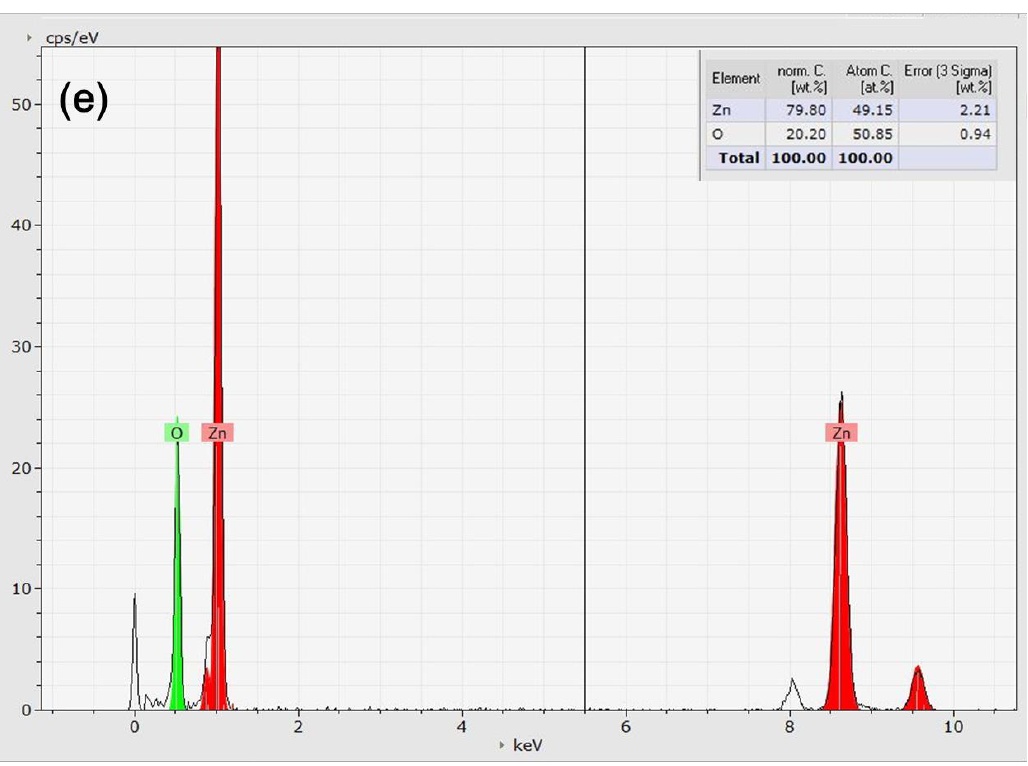
Catalysts 2019 , 9 , x FOR PEER REVIEW 7 of 12 Figure 6. ( a ) Low-resolution transmission electron microcopy image of ZnO NS after calcination. ( b ) High-resolution transmission electron microcopy image of ZnO NS (upper insets show the selective area electron diffraction pattern). ( c , d ) Energy dispersive X-ray mapping images of ZnO NS for Zn and O, respectively. ( e ) Quantitative EDX spectroscopy data for ZnO NS.